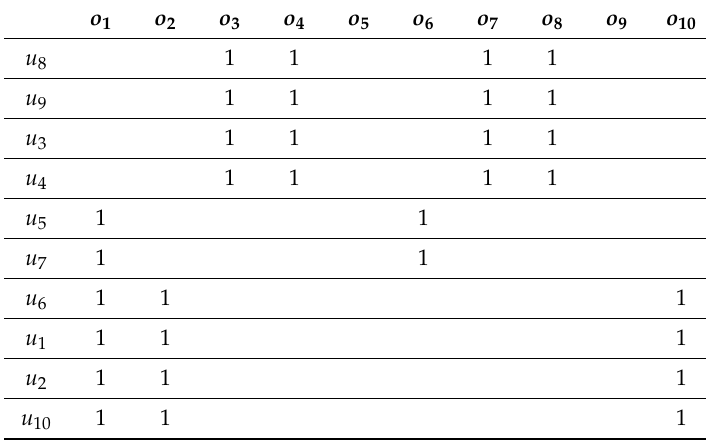
Table 8. Step 1 for rearrangement.